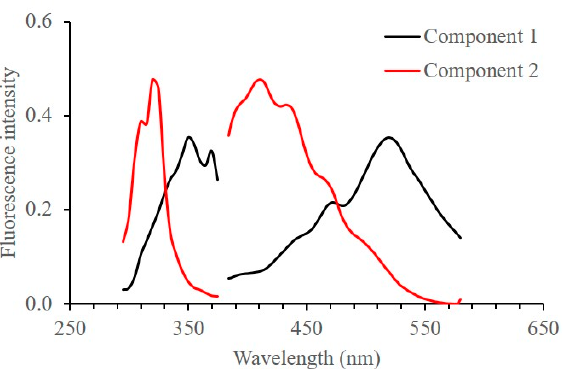
Figure 3. Excitation and emission PARAFAC loadings obtained with the complete set of samples.